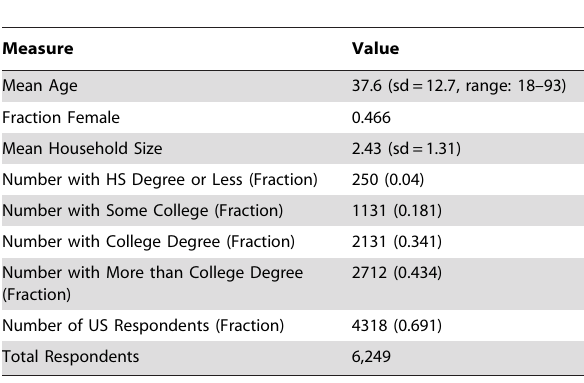
Table 1. Summary statistics for survey